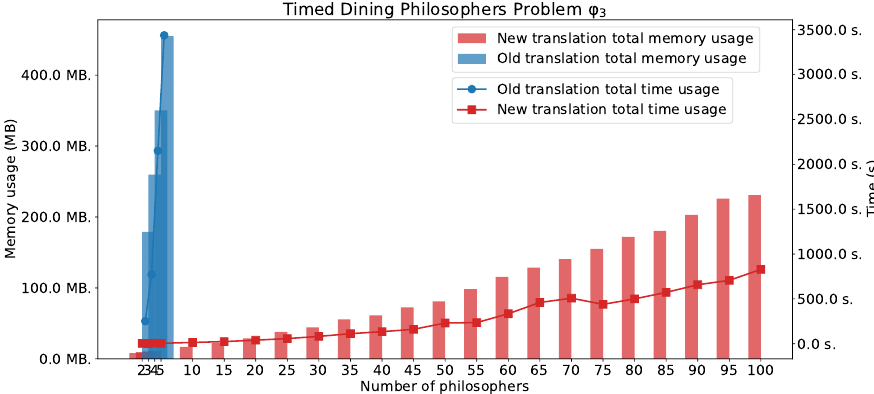
Figure 6. The TDPP with n philosophers: ϕ 3